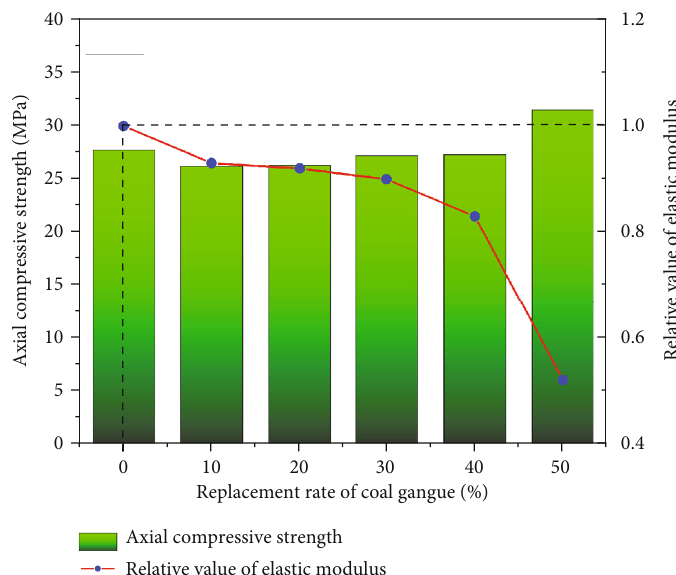
Figure 7: Axial compressive strength and elastic modulus of coal gangue fi ne aggregate